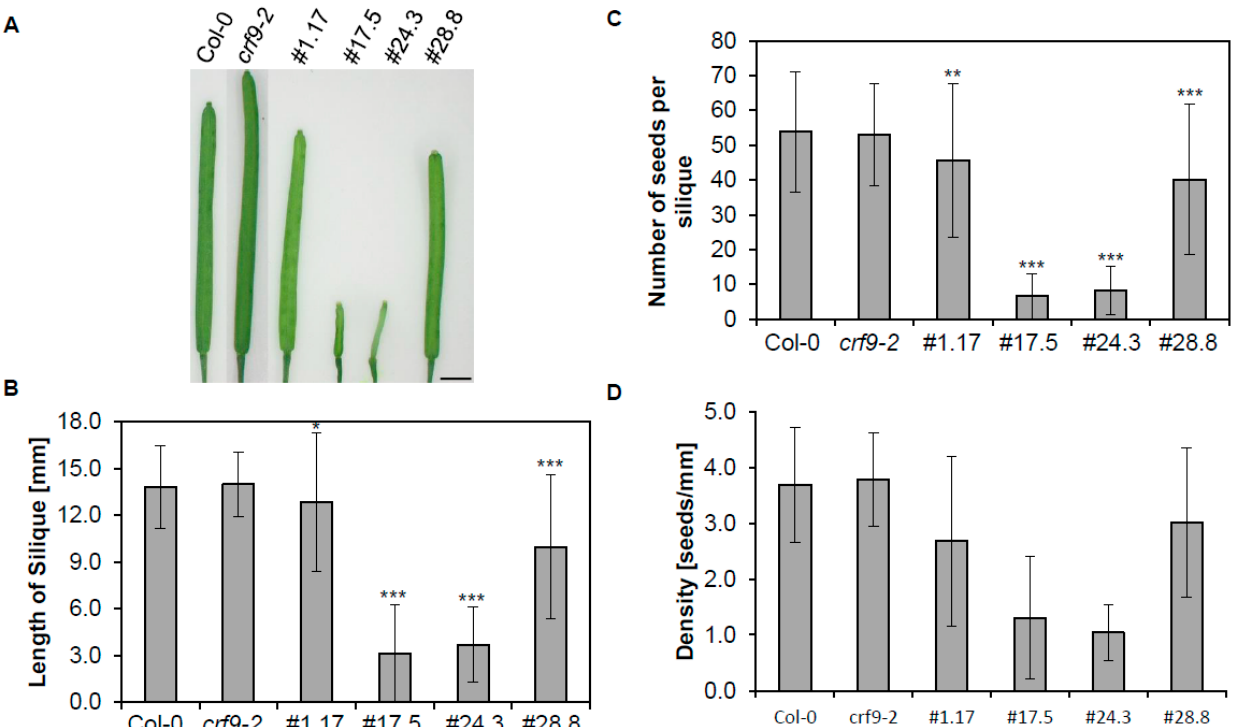
Figure 7. CRF9 seems to play a critical role in silique development. The different plant lines were grown under long-day conditions in the greenhouse. ( A ) Siliques at the end of their respective growth phase. ( B ) length of siliques ( n ≥ 120) ( C ) the average number of seeds per silique ( n ≥ 17) ( D ) seed density (number of seeds per mm of silique length ( n ≥ 17). Level of significance in a one-sided t -test: * = p < 0.05, ** = p < 0.01, *** = p < 0.001. The rule bar in ( A ) represents 2 mm.